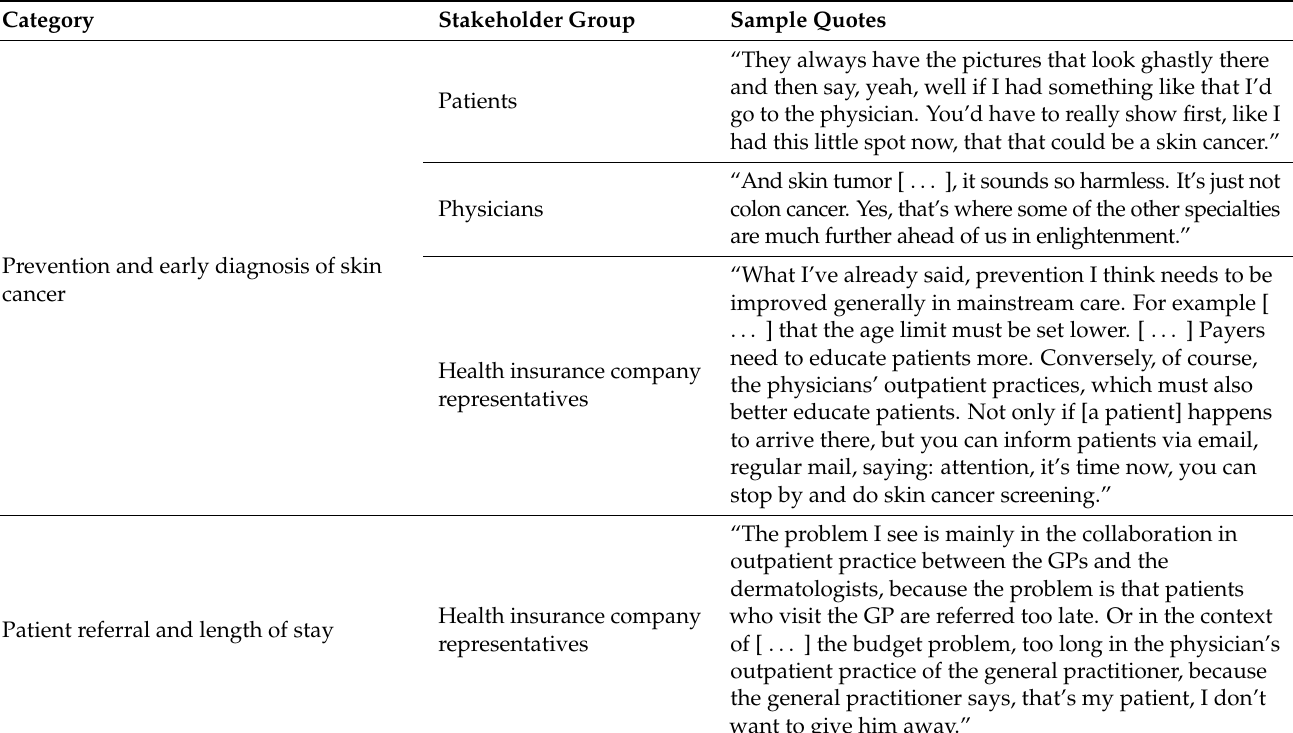
Table 3. Overview of the categories generated for the optimization potential in the care of patients with skin cancer in the study